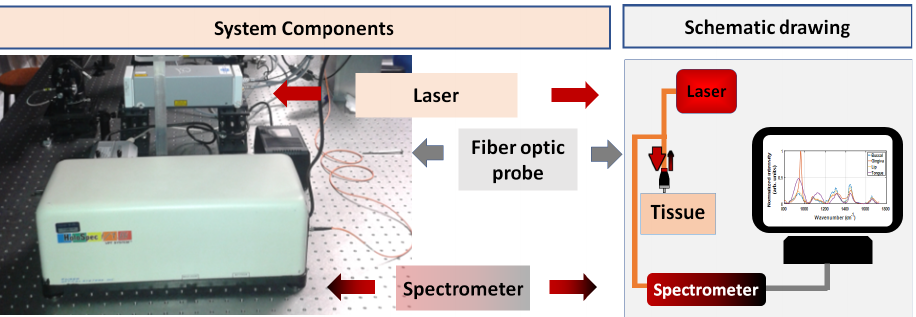
Figure 1. Components and schematic drawing of the Raman spectroscopy system used for the tissue measurements of our study. In this study, Raman spectra collected from gingiva tissue included signals from alveolar bone, teeth, periodontal ligament and gingiva, as illustrated in Figure 2.